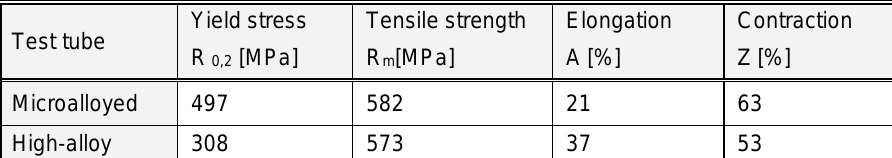
Table 7 – Mechanical properties of microalloyed and high alloy